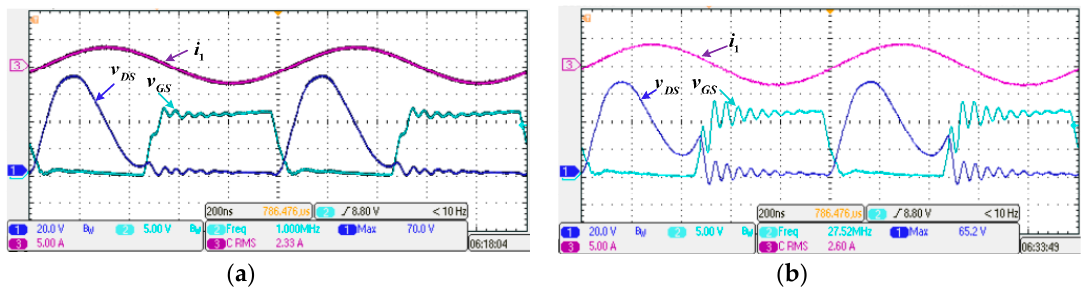
Figure 17. Waveforms of driver signal v GS , transmitter current i 1 , and drain-to-source voltage v DS , when iron plate at line l 2 . ( a ) d 2 = 15 cm; ( b ) d 2 = 10 cm.